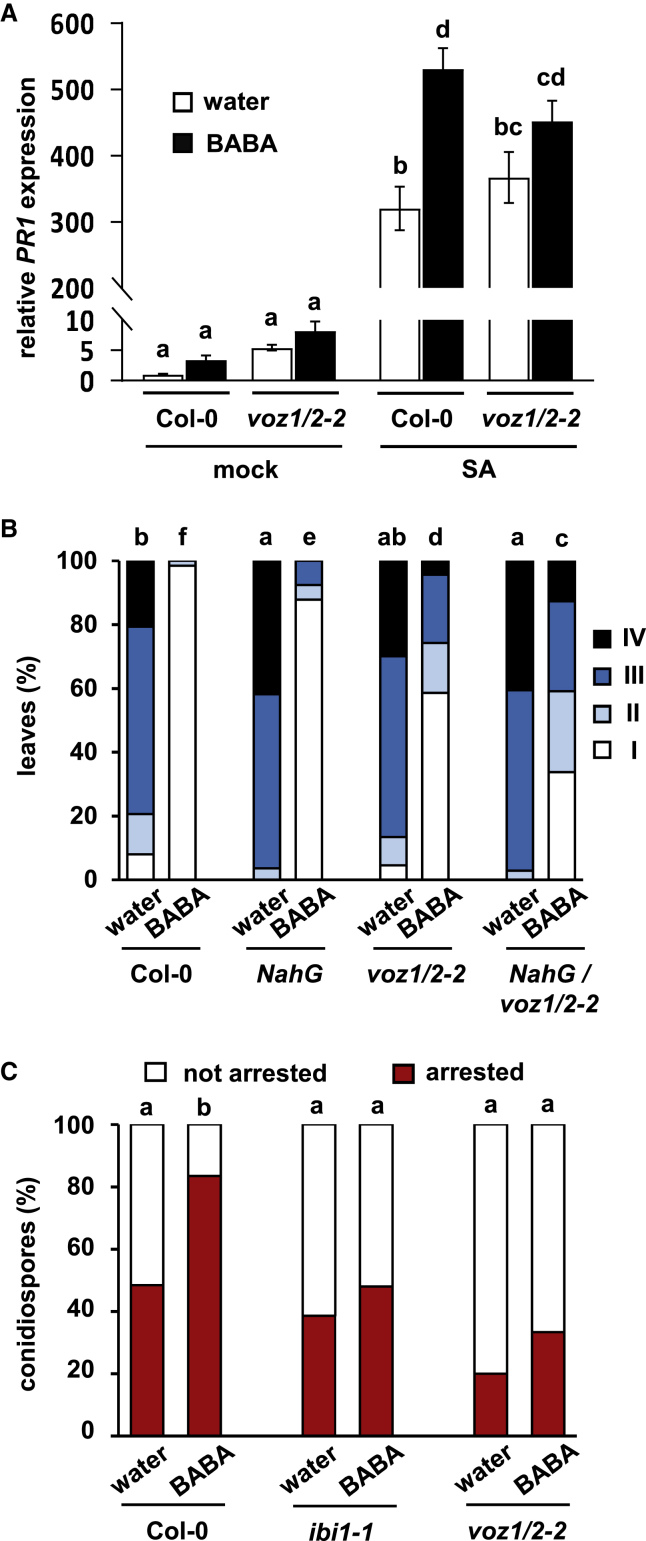
The Signaling Role of VOZ1 and VOZ2 in BABA-IR.(A) The voz1/2-2 mutant is partially compromised in BABA-induced priming of salicylic acid (SA)-induced PR1 expression. Leaves of water- and BABA-treated Col-0 and voz1/2-2 were sprayed with 1 mM SA at 2 days after soil-drench treatment of 2-week-old plants with water or BABA (5 mg/l). Shoots were harvested at 8 h after SA treatment for qRT–PCR analysis. Data shown are mean expression values (±SEM) of PR1 expression relative to water-treated mock-sprayed Col-0 plants. Different letters indicate statistically significant differences in expression (two-way ANOVA + Tukey's multiple comparisons test; p < 0.05; n = 4).(B) Introgression of the NahG gene in the voz1/2-2 mutant background further reduces its attenuated BABA-IR response, indicating that SA-dependent defense does not play a major role in VOZ1/2-dependent BABA-IR against Hpa. Two-week-old Col-0, NahG, voz1/2-2, and NahG voz1/2-2 plants were soil-drenched with water or 5 mg/l BABA and inoculated with Hpa 2 days later. Disease progression was assessed at 5 dpi by assigning trypan blue-stained leaves to different Hpa colonization classes (Supplemental Figure 6). Different letters indicate statistically significant differences in class distribution between samples (Fisher's exact tests + FDR; p < 0.05; n = 55–71 leaves).(C) The voz1/2-2 mutant is impaired in BABA-induced priming of callose-associated cell wall defense. Two-week-old Col-0, ibi1-1, and voz1/2-2 plants were soil-drenched with water or 5 mg/l BABA and inoculated with Hpa 2 days later. Callose effectiveness was analyzed at 3 dpi in aniline blue/calcofluor-stained leaves by epifluorescence microscopy. Shown are percentages of callose-arrested and non-arrested germ tubes at the epidermal cell layer (Supplemental Figure 7). Letters indicate statistically significant differences between samples (Fisher's exact tests + FDR; p < 0.05; n = 31–105 conidiospores).